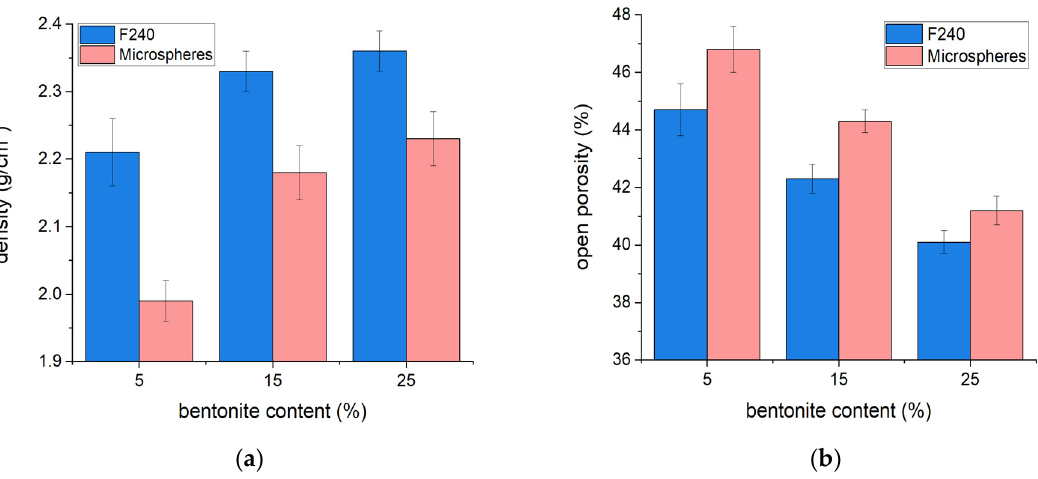
Figure 9. ( a ) Density and ( b ) open porosity of alumina ceramics based on electrocorundum F240 and hollow alumina microspheres produced by direct casting with different amounts of bentonite binder.